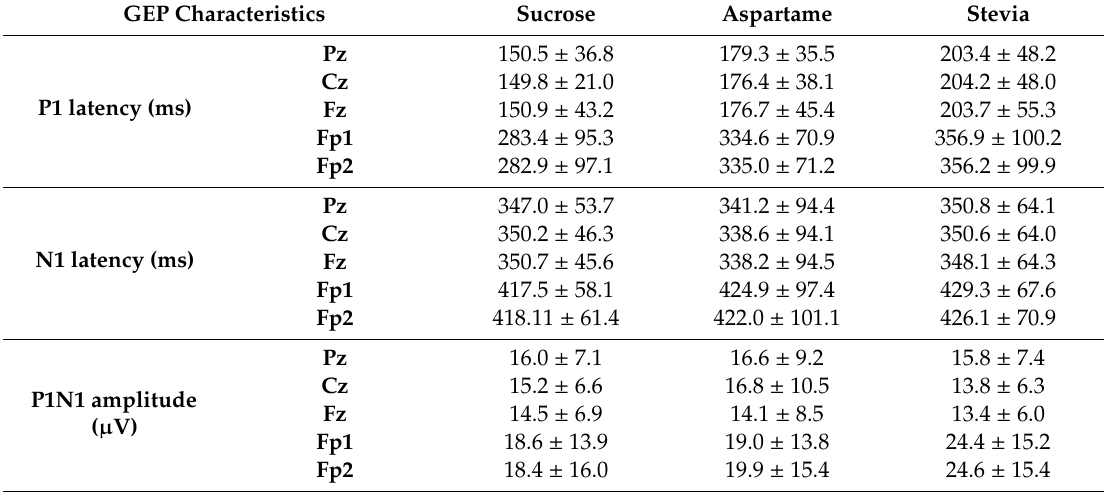
Table 2. Mean ± SD of the GEPs parameters (P1 latency, N1 latency, and P1N1 amplitude) recorded in response to the three sweet solutions on the Pz, Cz, Fz, Fp1, and Fp2 electrodes, in the 20